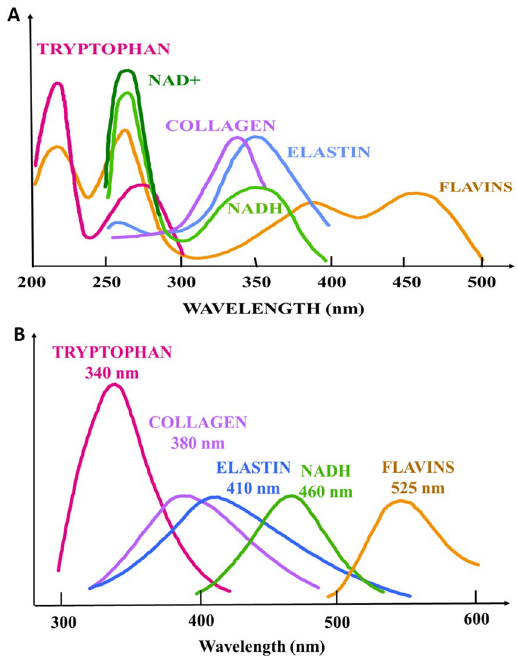
Figure 2. Absorption and fluorescence profiles of key biomolecules. ( a ) Absorption of key molecules, and ( b ) emission of key